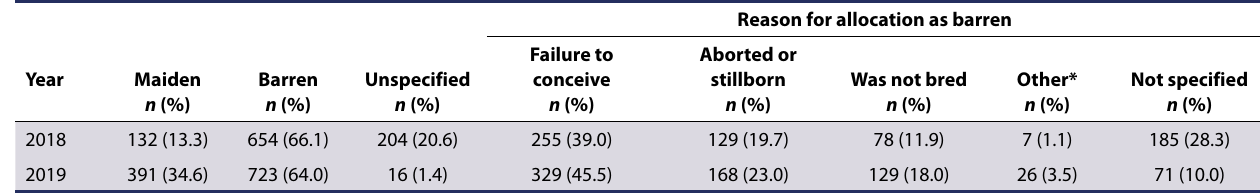
barren mare descriptively decreased for the second year of the study (Table II). The most common reason for allocation as a barren mare was failure to conceive at 39.0% (2018) and 45.5% (2019) (Table II). Table II: Summary of the reproductive status categorisation of Thoroughbred mares tested as part of the 2018 ( n = 990) and 2019 ( n = 1 130) South African stud health scheme and reason for allocation as a barren mare in 2018 ( n = 654) and 2019 ( n = 723)